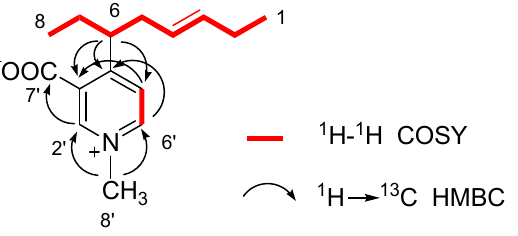
HMBC correlations of simplexidine ( 4 ). C-H